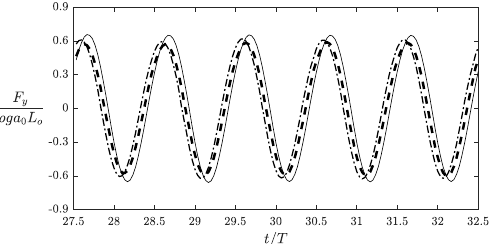
Figure 22. Time histories of dimensionless vertical force exerted on a submerged obstacle. Solid line: d m = 0 (solid bottom). Dashed line: d m = δ m . Dashed-dotted line: d m = 3 δ m . See Figure 18 for other model